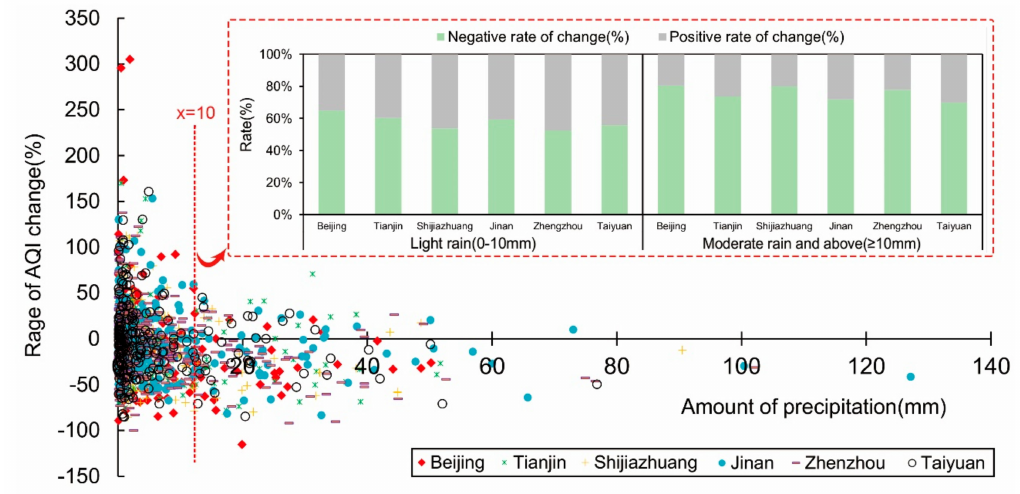
Figure 8. The influence of precipitation on air quality. There were 1297 rainy days in the six provincial capitals during 2014 and 2016, with light rain (0–10 mm) accounting for 78.3% of the